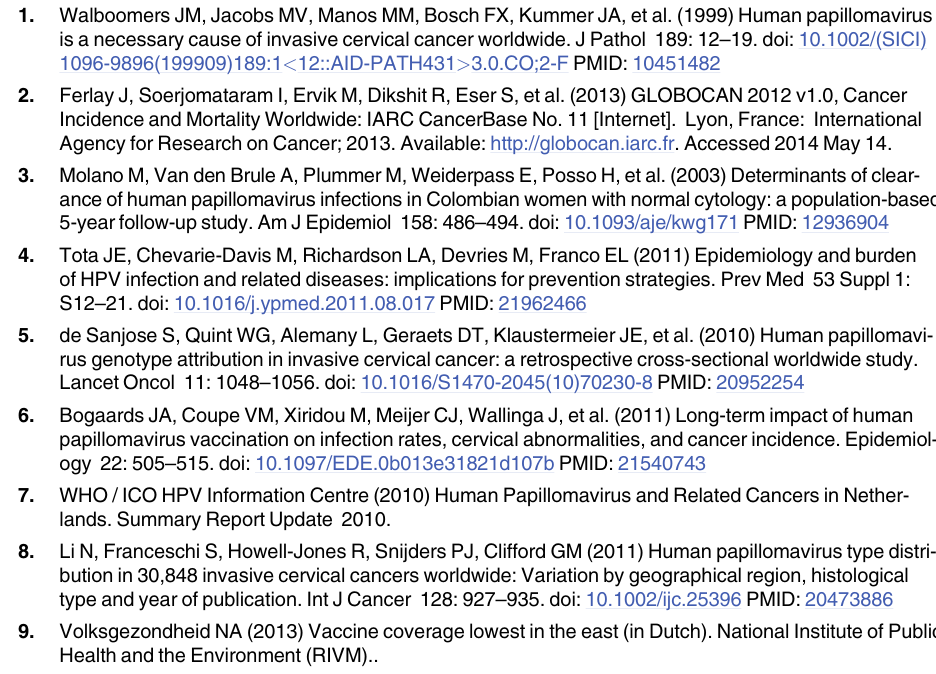
S4 Table. Observed high-risk HPV (hrHPV) prevalence with the type-specific fractions and the corresponding type-specific prevalence per age group. The observed high-risk HPV prev- alence is based on the studies of Lenselink et al . and Bulkmans et al . By applying the fractions observed in Coupé et al ., we obtained the type-specific HPV-16 and HPV-18 prevalence. S5 Table. Parameter values and goodness-of-fit for the best fitting HPV-16 and HPV-18 models of the different scenarios and both acquired immunity mechanisms. The scenarios include no acquired immunity; exponentially distributed durations (Weibull shape = 1); and Weibull distributed durations. S6 Table. Parameter values and the distribution of immunity durations for the best fitting HPV-16 and HPV-18 models under the base case and alternative immunity mechanism. Scenarios include no acquired immunity; exponentially distributed duration (Weibull shape = 1); and Weibull distributed